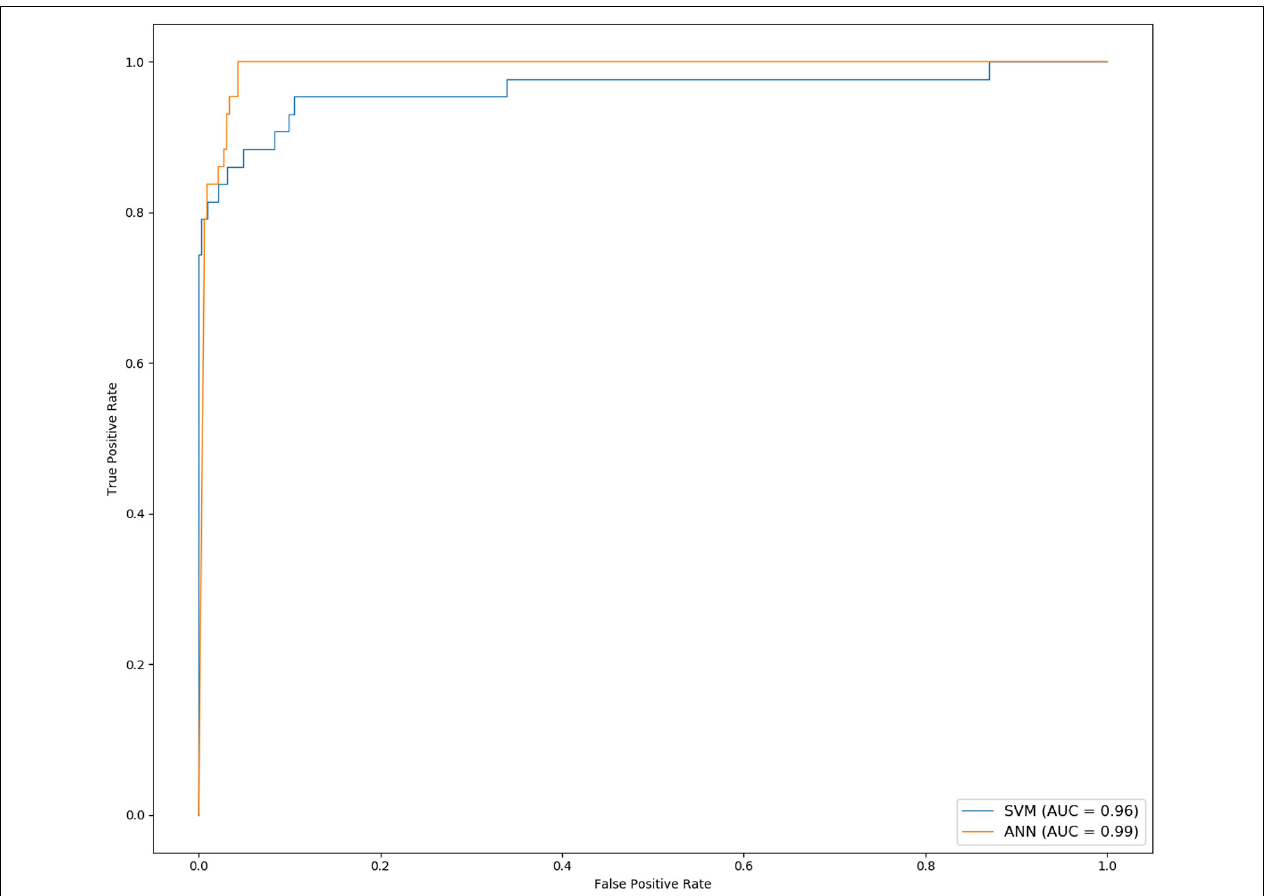
FIGURE 6 | The ROC and AUC of ANN and